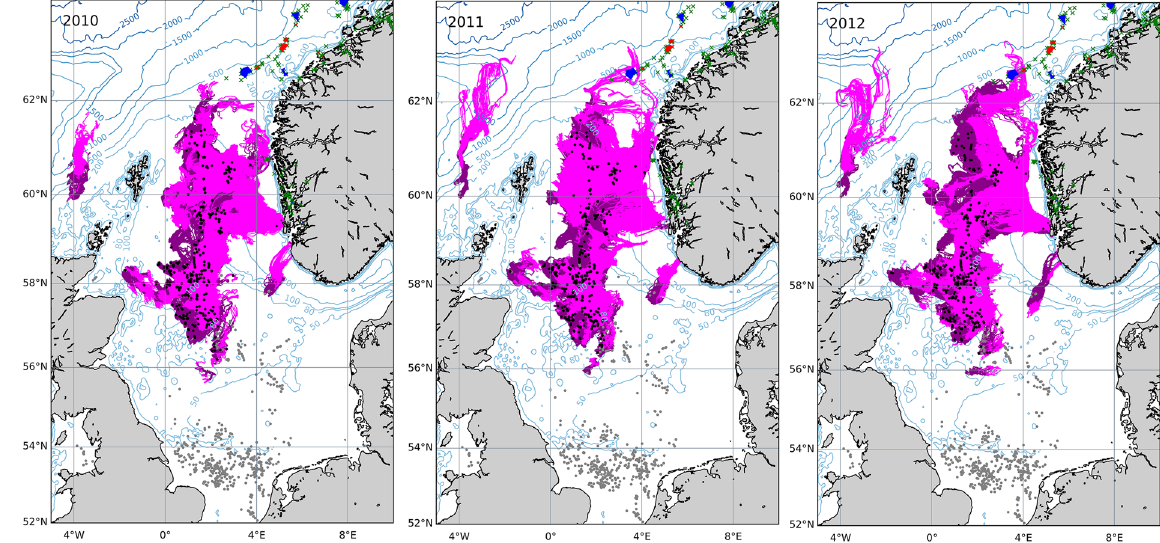
Figure 4. Inter-annual variability in dispersal pathways of coral larvae released from North Sea oil and gas structures. Bathymetric depth contours in metres illustrate pathways of pre-competent (dark pink) and competent (light pink) larvae over deep-sea, shelf and fjordic coral ecosystems. Blue and red polygons indicate coral marine protected areas and zones of high coral density, respectively. Black (grey) dots indicate oil and gas structures included (excluded) from the analyses. Green crosses indicate occurrences of natural populations off the coast of